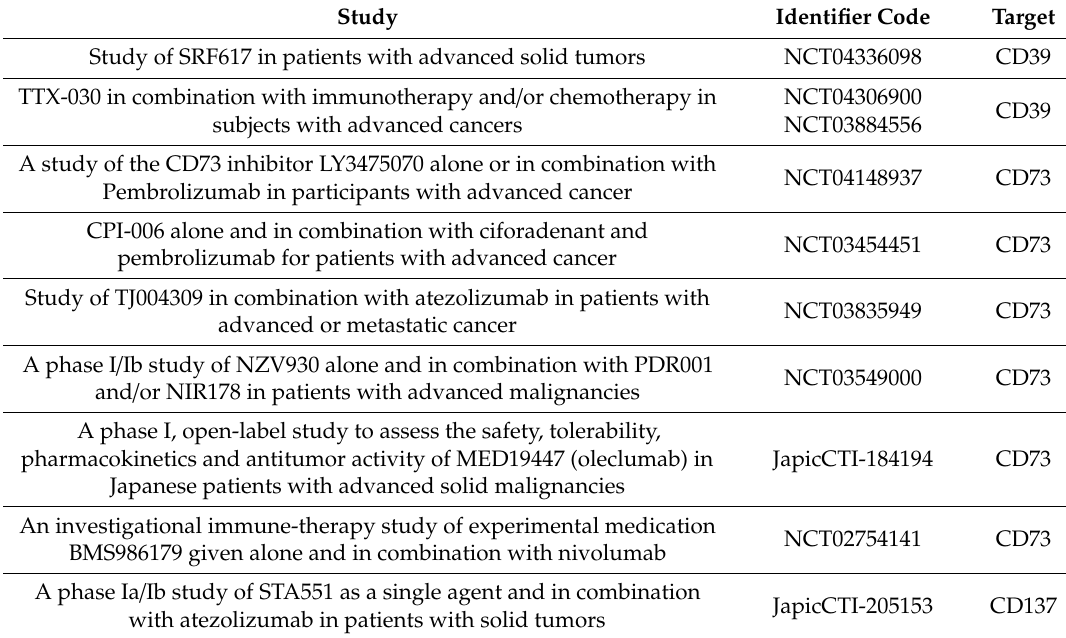
Table 1. Overview of clinical trials targeting eATP in the